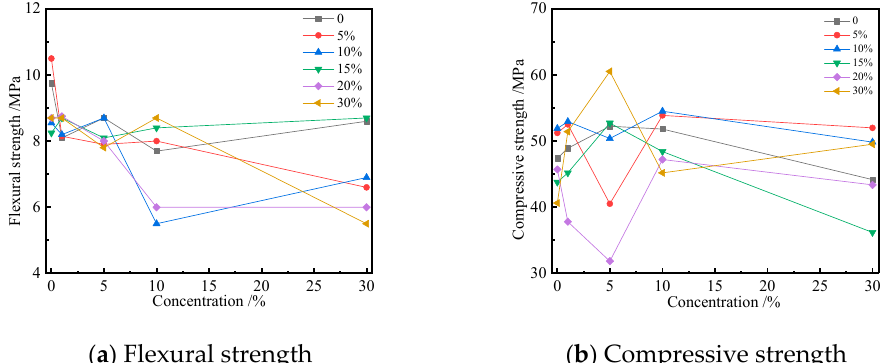
Figure 6. Variation curves of the strength of mortars containing slag attacked by sulfate solutions for two months.